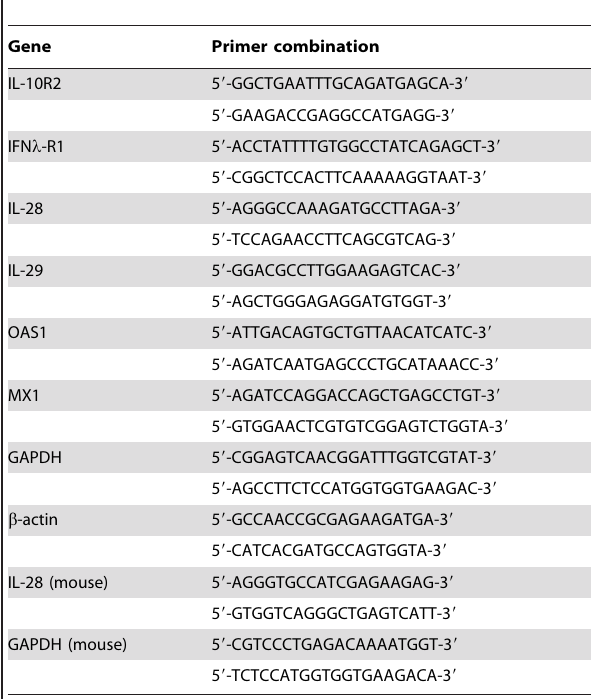
Table 1. Primers used for PCR and quantitative